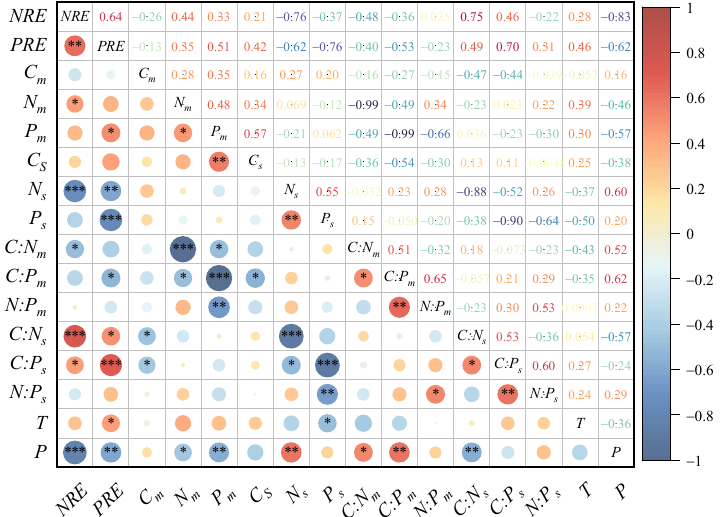
Figure 6. Correlation of nutrient contents, resorption efficiencies, and stoichiometric ratios with climatic factors in the Castanopsis carlesii plantation. NRE : N resorption efficiency; PRE : P resorption